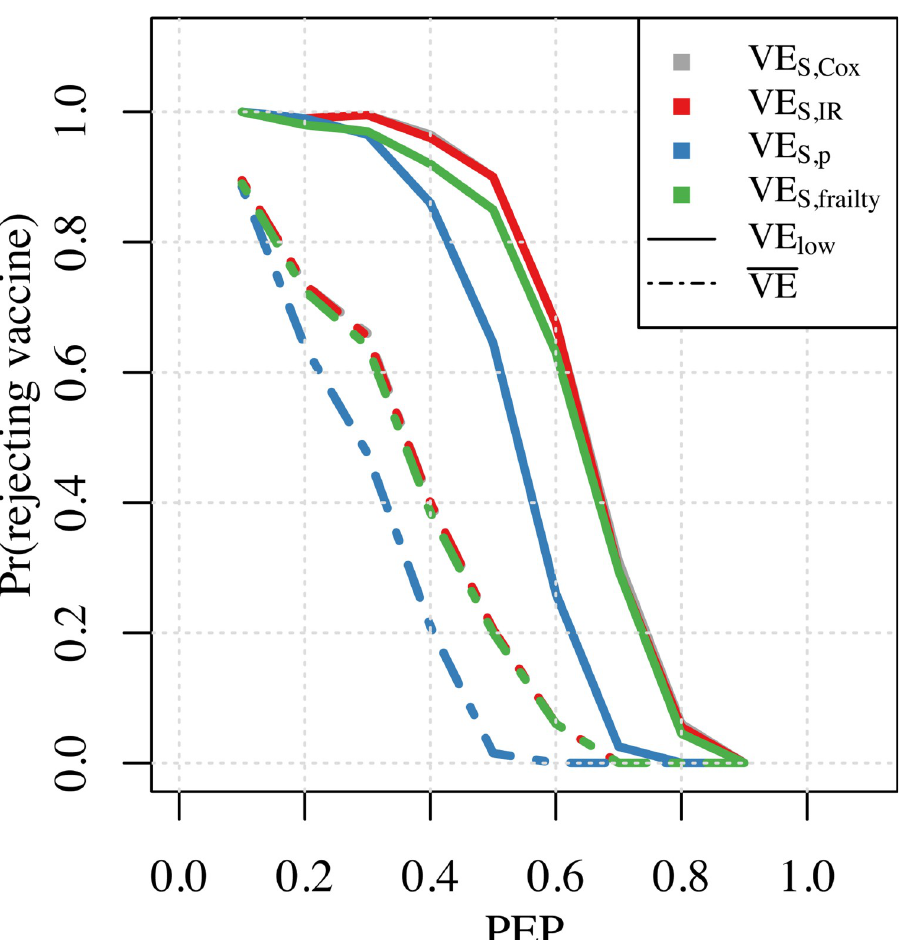
Fig 4. Probability of not licensing a vaccine with MPP = 0.3 at different input PEP values. Solid lines represent the probability of rejection calculated as the proportion of simulations where the lower bound of the confidence interval of VE S was below MPP. Dotted lines represent the probability of rejection calculated as the proportion of simulations where the mean estimate of VE S was below MPP.